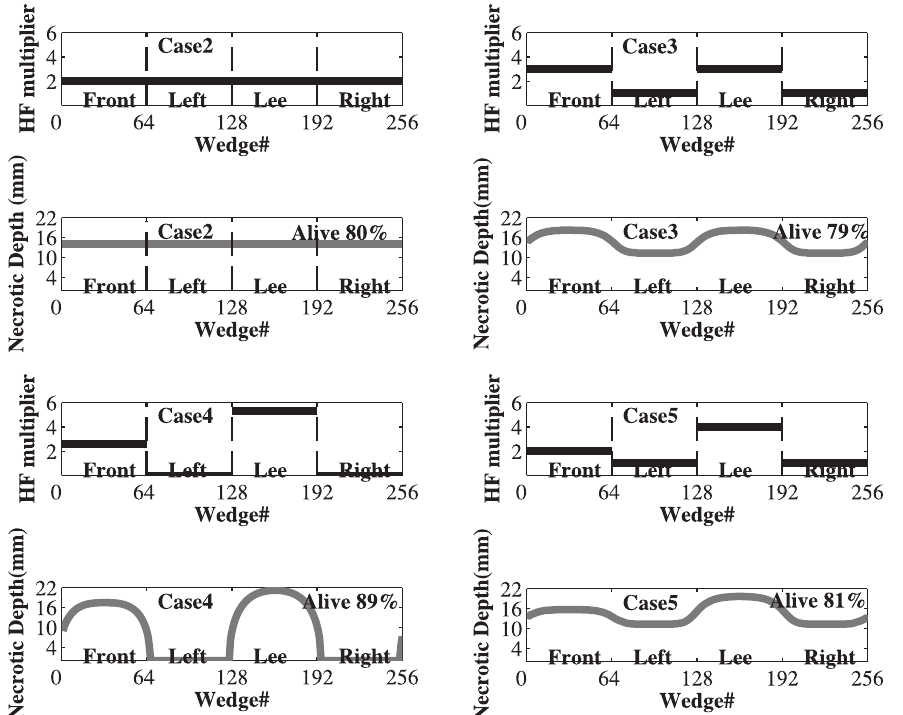
Figure 9. Forcing pattern and necrotic depth results for Cases 2–5. For each case, the upper panel plot shows (black line) how heat forcing was applied around the tree stem and the lower panel for the same case presents the Necrotic Depth (grey line) of each wedge of the stem. Plot layout is the same as panels B and D in figure 8. Case 2. Heat forcing was applied evenly around the tree stem. Case 3. 3/8 of heat forcing was applied at each of the front and lee side and 1/8 at each of the other sides. Case 4. 2.67/8 of heat forcing was applied at front side and 5.33/8 at the lee side. Case 5. 2/8 of heat forcing was applied at front side, 4/8 at lee side, and 1/8 at the left and right sides. Our simulation results show that different heating scenarios and heterogeneity of the heat flux around the stem can have different effects on the resulting necrosis and its potential to girdle the tree stem and lead to mortality.